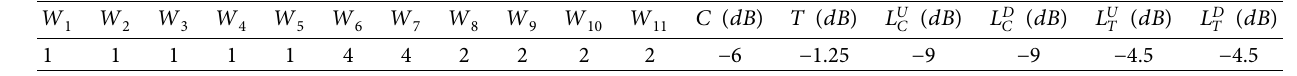
Table 4: Values of (9) for design 6dB ATRD coupler has been described in Example 2. W 1